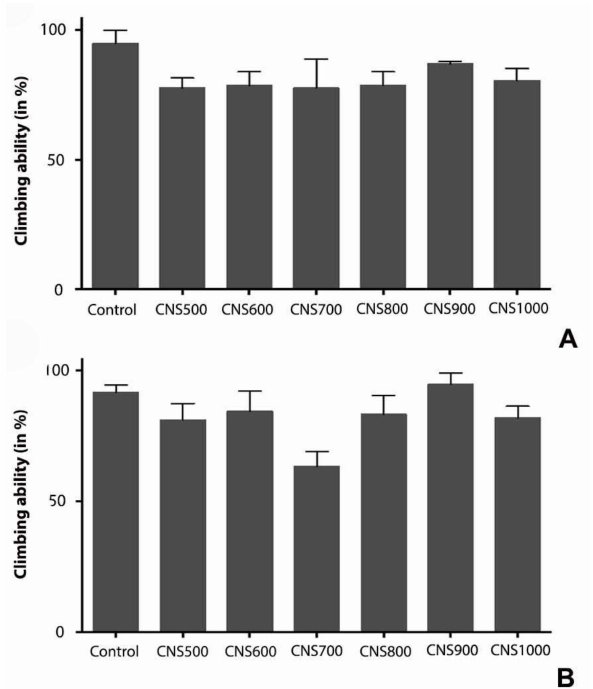
Figure 6. Negative geotaxis or climbing assay in carbon-nanoparticle-treated ( A ) male and ( B ) female flies. Both male ( A ) and female ( B ) flies were tested for their negative geotaxis behavior after 25 days of carbon nanoparticle treatment at 1000 µ g/mL dose. The values represented are mean ± SEM and statistical significance was set at p < 0.05 when compared to control (n = 3 and 25 flies per treatment and control